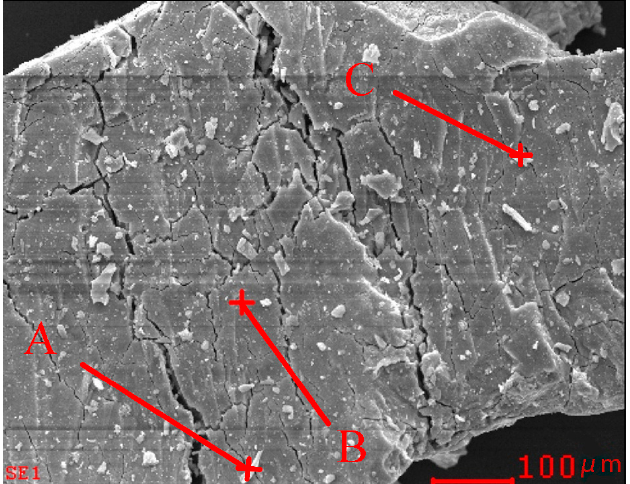
Figure 8. SEM micrographs of as-cast TiFe 0.86 Mn 0.07 Co 0.07 + 4% Mm. Table 4. Elemental analysis of as-cast TiFe 0.86 Mn 0.07 Co 0.07 + 4% Mm.